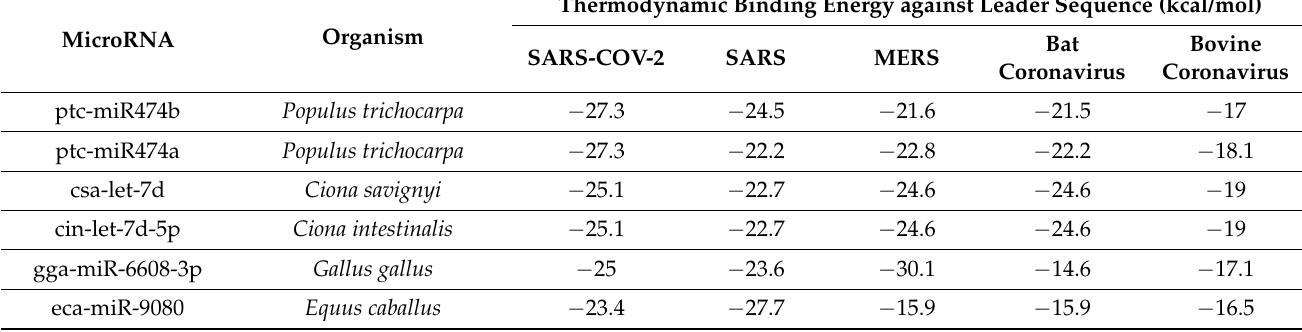
Table 3. MicroRNAs potentially able to bind to the leader sequence of the coronavirus 5 (cid:48) untranslated region (5 (cid:48) UTR) and their binding energy. Lower binding energy demonstrates higher binding stability between microRNA and leader